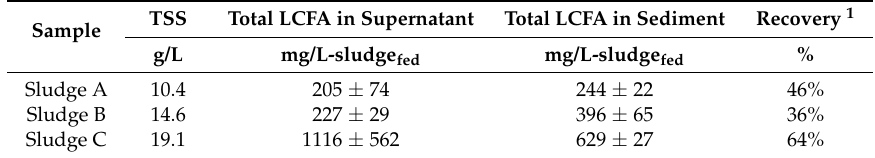
Table 2. LCFA recoveries in the supernatant and sediment obtained after pretreatment for QCM sensor ( n =